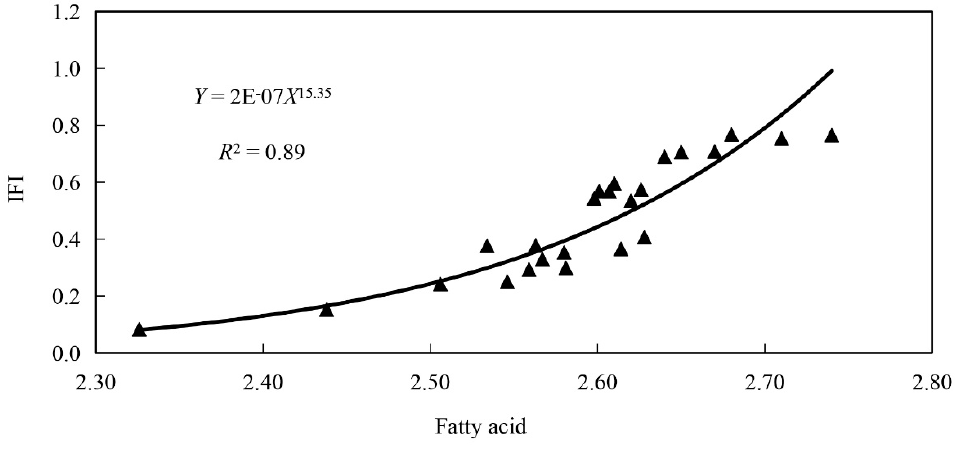
Figure 4. The relationship between the fatty acid diversity of soil microorganisms and soil fertility.